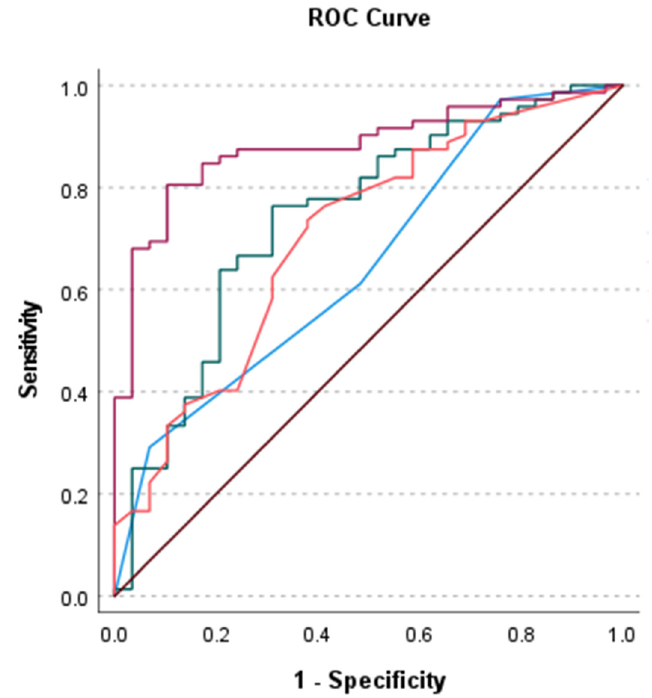
Figure 2. Receiver operator characteristic curves for atypia severity (blue), modified Herder score (green), pack years (orange) and model including atypia severity, modified Herder score, and pack years (magenta) predicting final diagnosis. Reference line (brown).